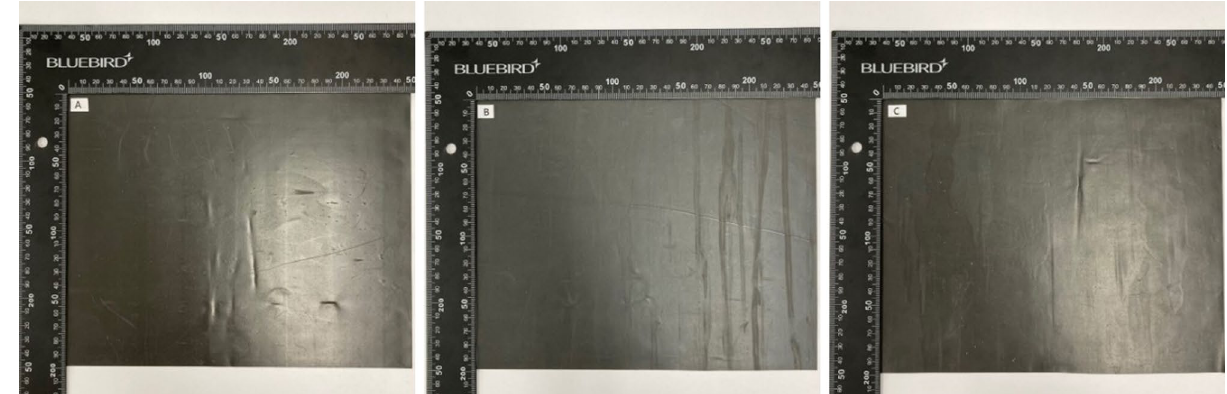
Figure 1. The three types of shielding films produced in the study. ( A ) Single-sided dispersion method shielding film (SSF, 25 cm × 20 cm). ( B ) Double-dispersion method shielding film (DSF, 25 cm × 20 cm), and ( C ) air pressure mirroring particle dispersion method shielding film (MSF, 25 cm × 20